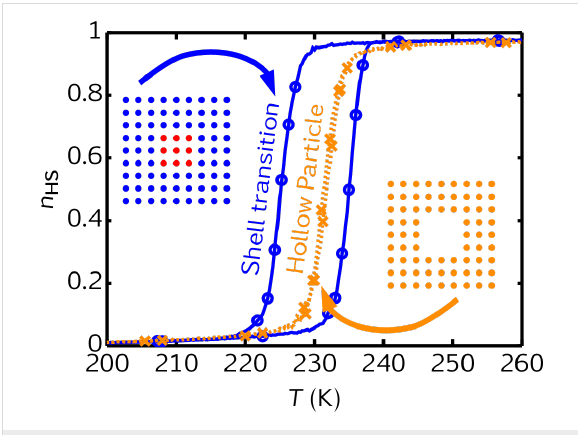
Figure 10: Comparison between the thermal SCO curves of a 9 × 9 hollow particle with a 3 × 3 hole and a 9 × 9 shell surrounding a 3 × 3 active core. Adapted with permission from [41], copyright 2014 Else-